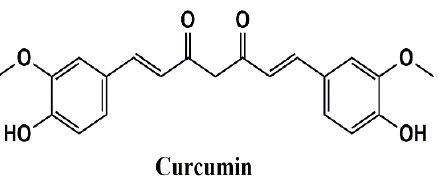
Figure 1. Chemical structure of curcumin, the active compound of the spice turmeric.